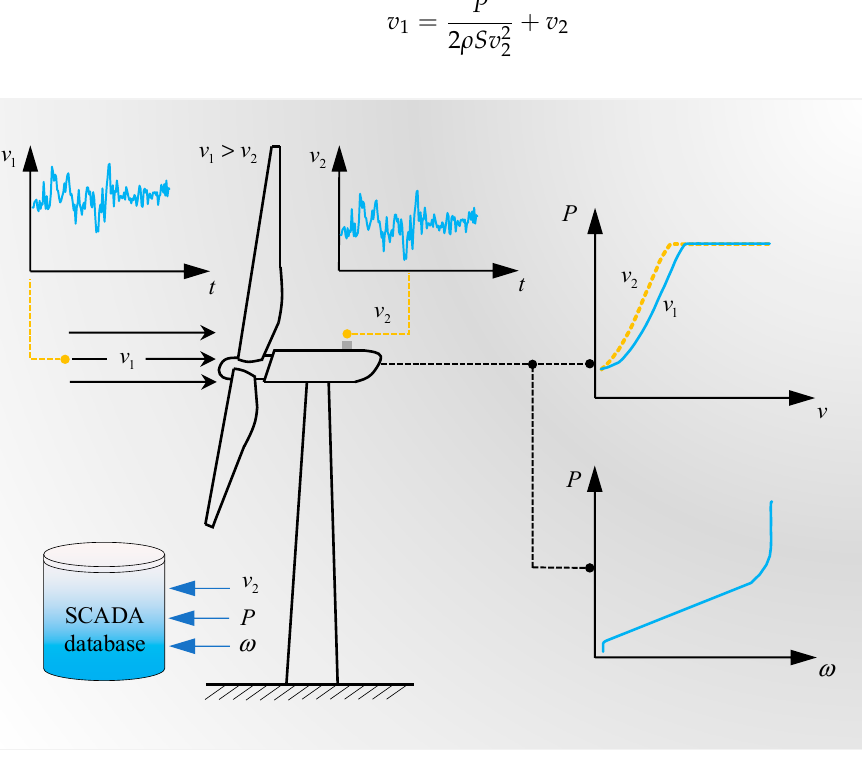
Figure 3. Power curves based on di ff erent wind speeds.